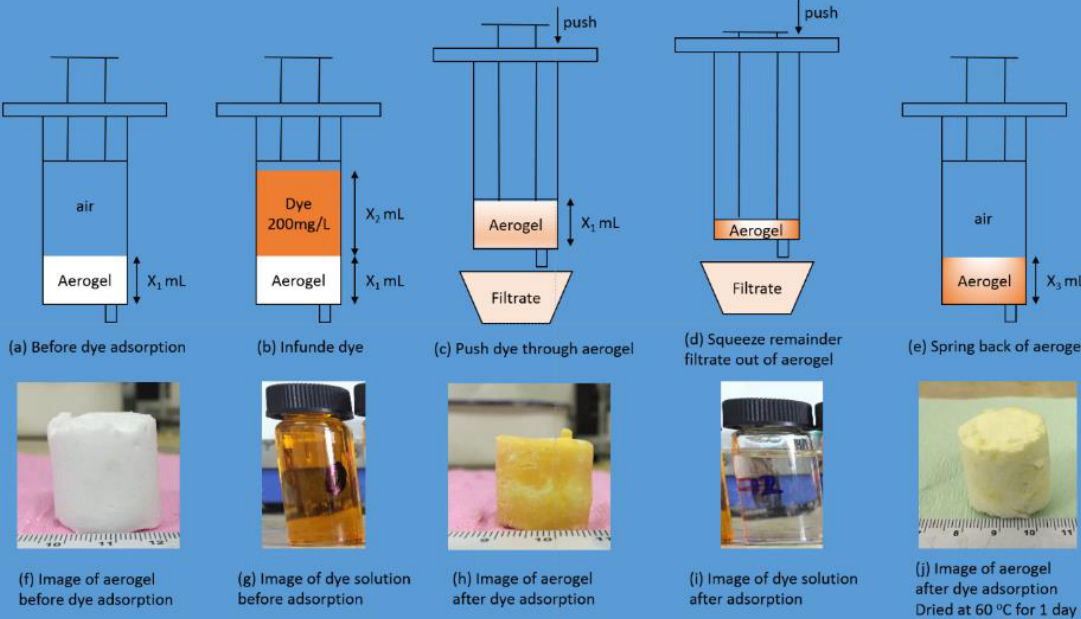
Figure 11. Sketch maps of fast dye adsorption facility.